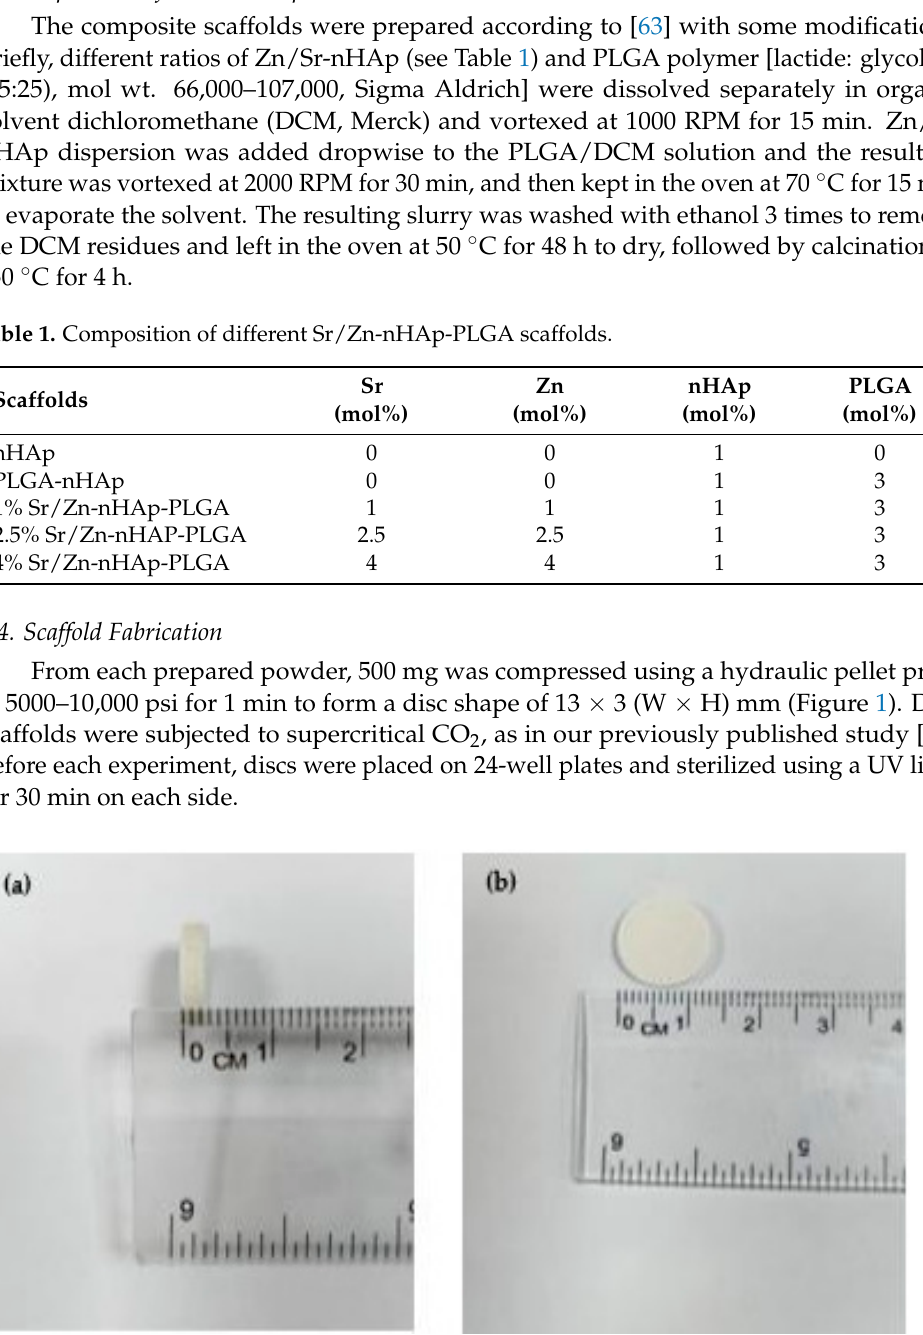
Table 1. Composition of different Sr/Zn ‐ nHAp ‐ PLGA scaffolds.